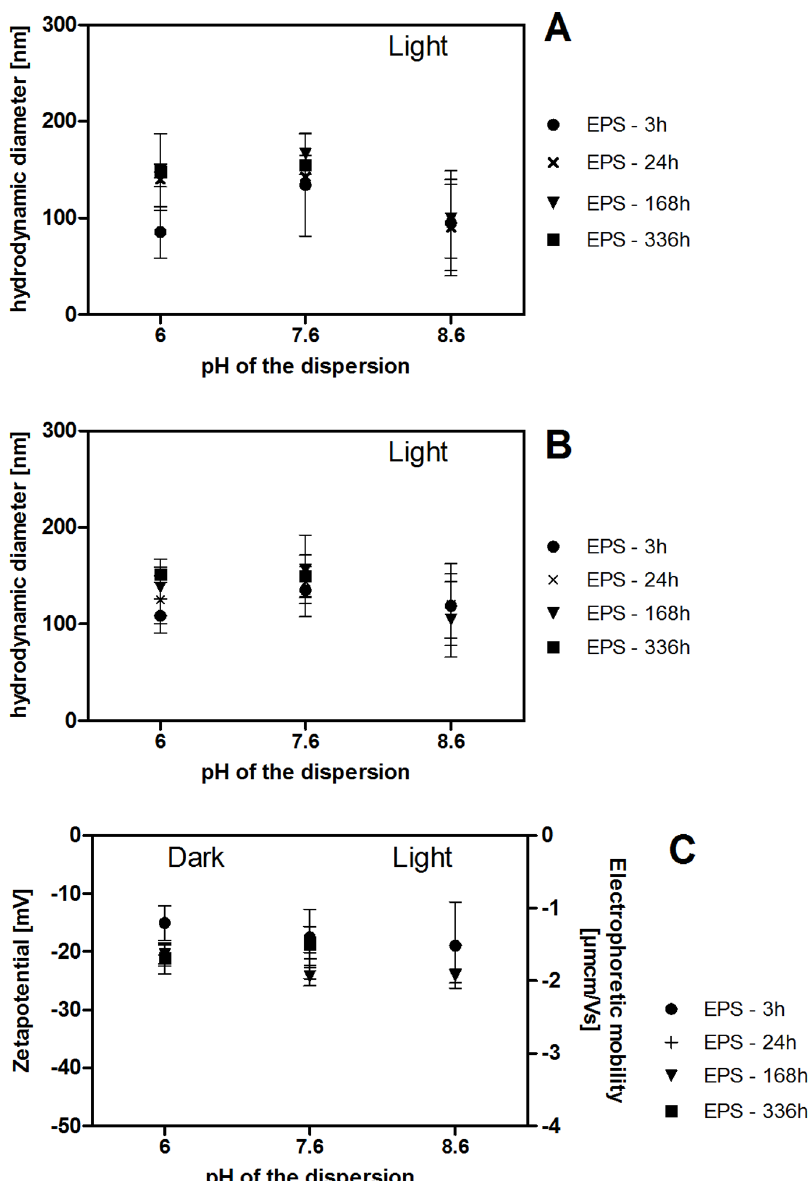
Figure 8. A–C: Mean hydrodynamic diameter of NP formed from AgNO 3 (5 mg/L dispersions) with standard deviations as determined DLS (intensity distribution (A) and NTA (B). Mean EPM and zetapotential with standard deviations determined by electrophoresis/DLS (C). Samples were incubated in light (100 m E/m 2 s). 3 h: n=15, 5 independent experiments (EPS extracts 1–5, 10 mg DOC/L). 168 h: n=12, 4 independent experiments (EPS extracts 1–3, 5). 336 h: n=3, 1 experiment (EPS extract